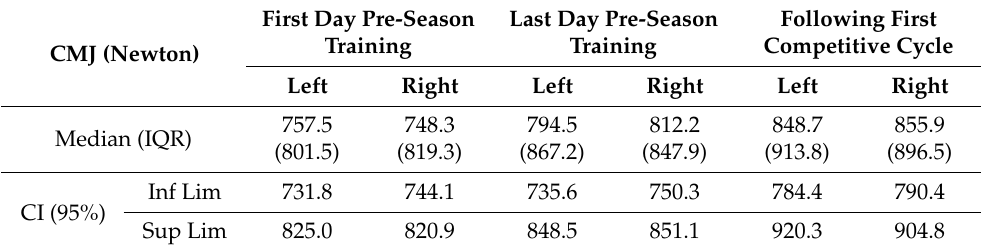
at 95%) at the first and last day of pre-season training and following first competitive cycle.